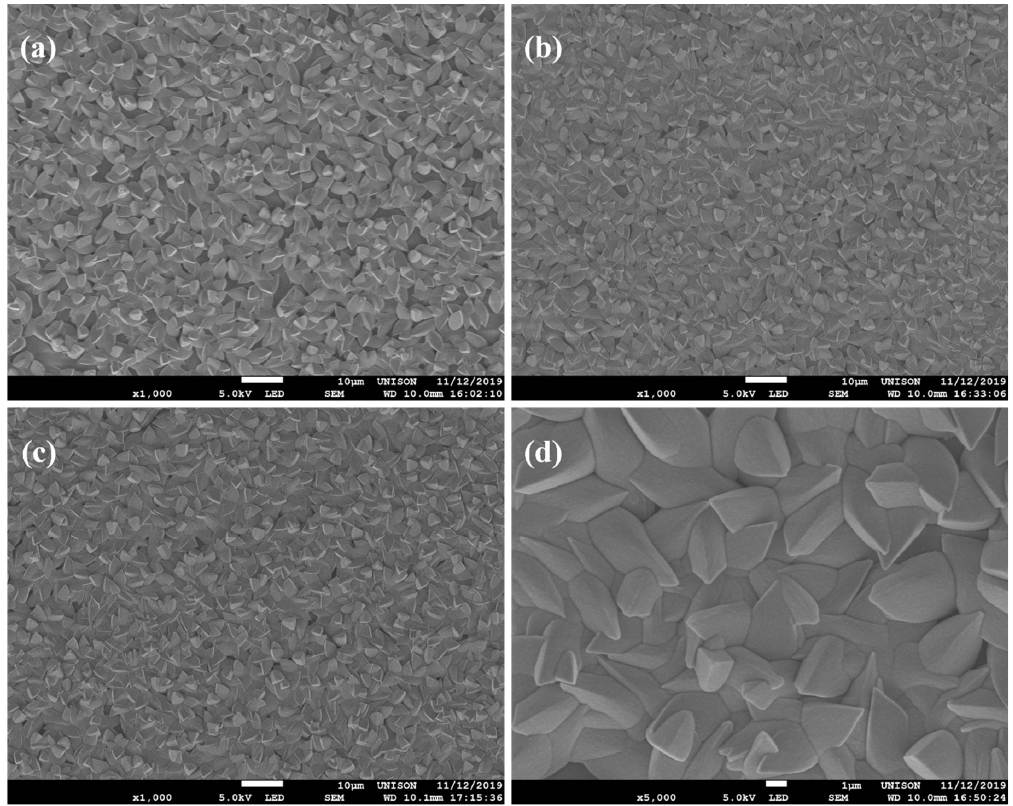
Figure 4. SEM micrographs of the CdCO 3 samples deposited at ( a ) 10, ( b ) 11, and ( c ) 12 h; ( d ) micro- graph of the deposited sample at 11 h with higher magnification.